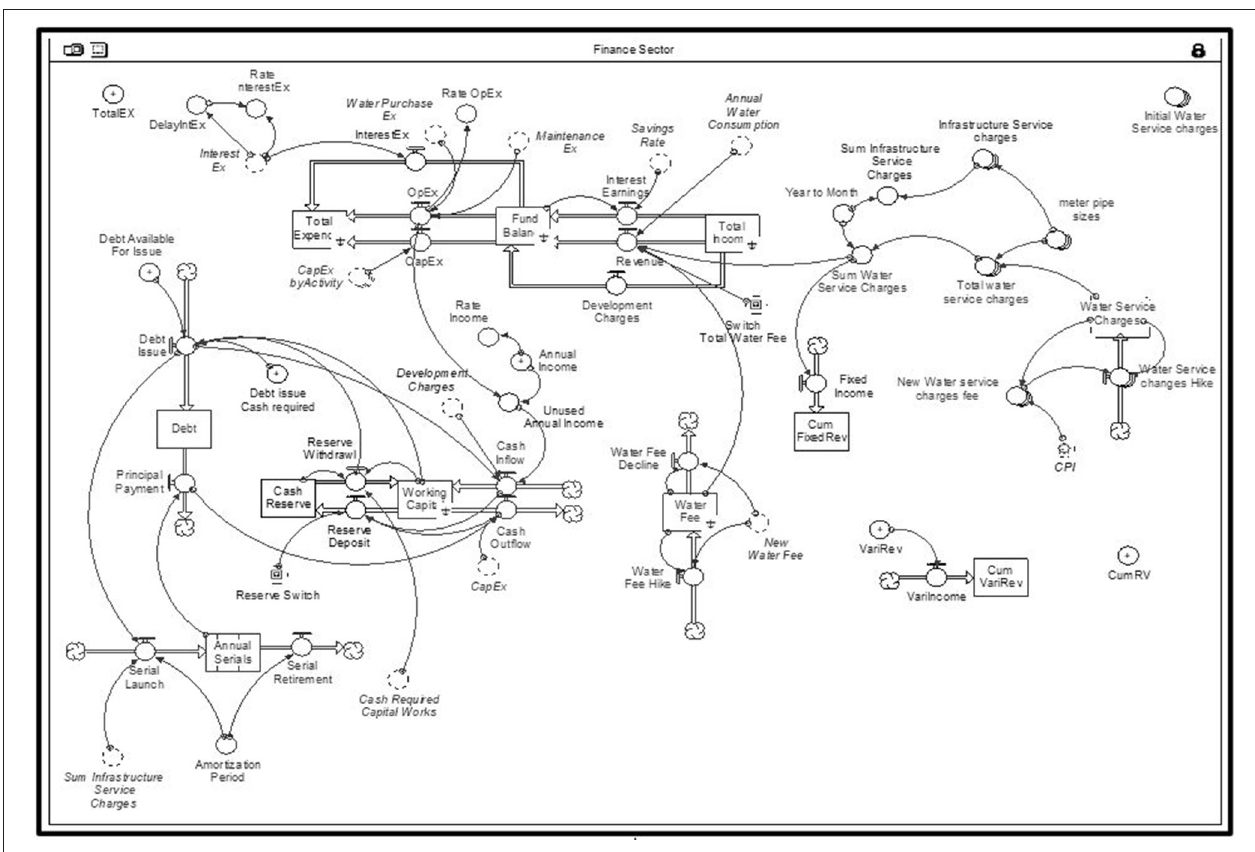
FIGURE 4 | Finance sector of the advanced system dynamic model in Stella ®